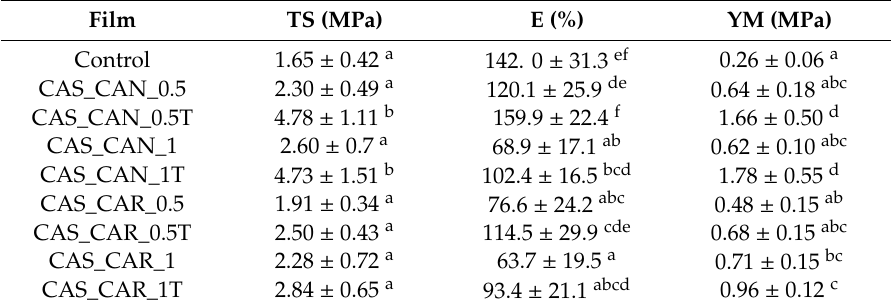
Table 6. Tensile strength (TS), Young’s modulus (YM), and elongation at break (E) of sodium caseinate films with candelilla and carnauba